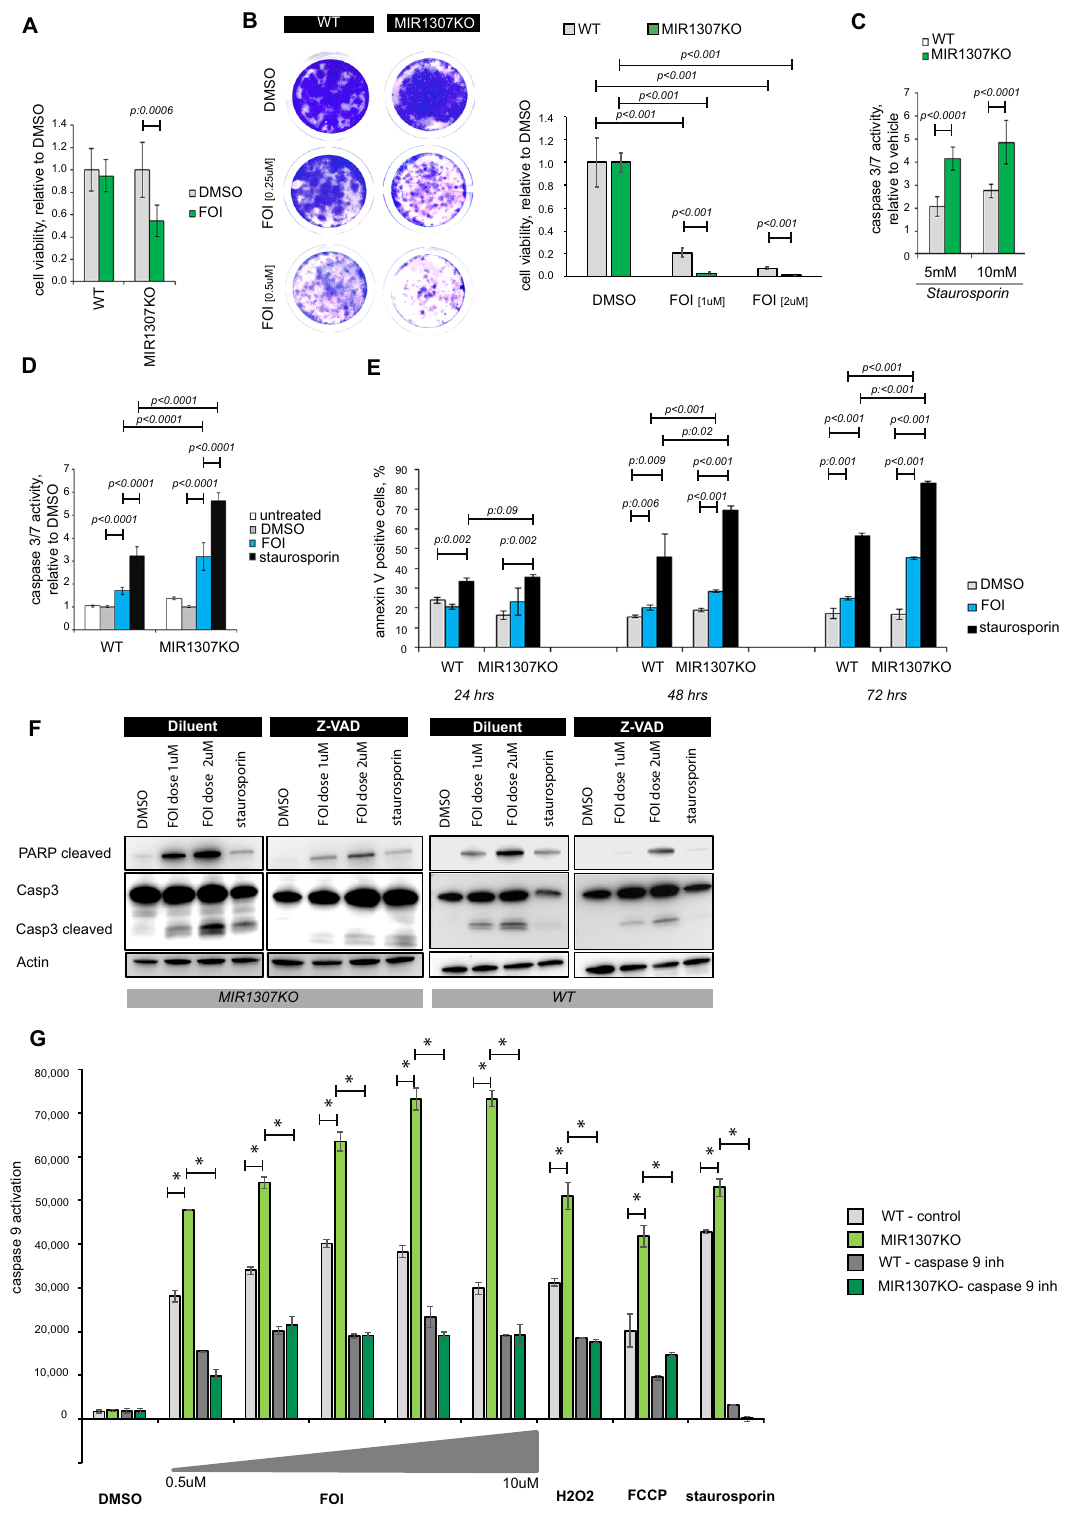
in a dose-dependent fashion in MIR1307KO in comparison to were con fi rmed to be more sensitive to olaparib, but not to wild-type (WT) MiaPaCa2 cell lines (Supplementary Fig. 3G, H). gemcitabine (Fig. 1J, K). Combined FOI chemotherapy for 48 h When the drugs were used separately, disruption of MIR1307 reduced cell viability by 40% in MIR1307KO MiaPaca2 cells changed sensitivity to oxaliplatin and partially to fl uorouracil (Fig. 2A). Clonogenic survival assay con fi rmed a long-term effect (Fig. 1G, H), while no effects were recorded for irinotecan of MIR1307 on chemotherapy sensitivity (Fig. 2B). (Fig. 1I), suggesting that the activity is likely related to platinum In line with these data MIR1307KO cells were more prone to DNA damage response. Indeed, MIR1307KO cells undergo apoptosis than control cells when treated with staurosporin NATURE COMMUNICATIONS| (2021) 12:6738